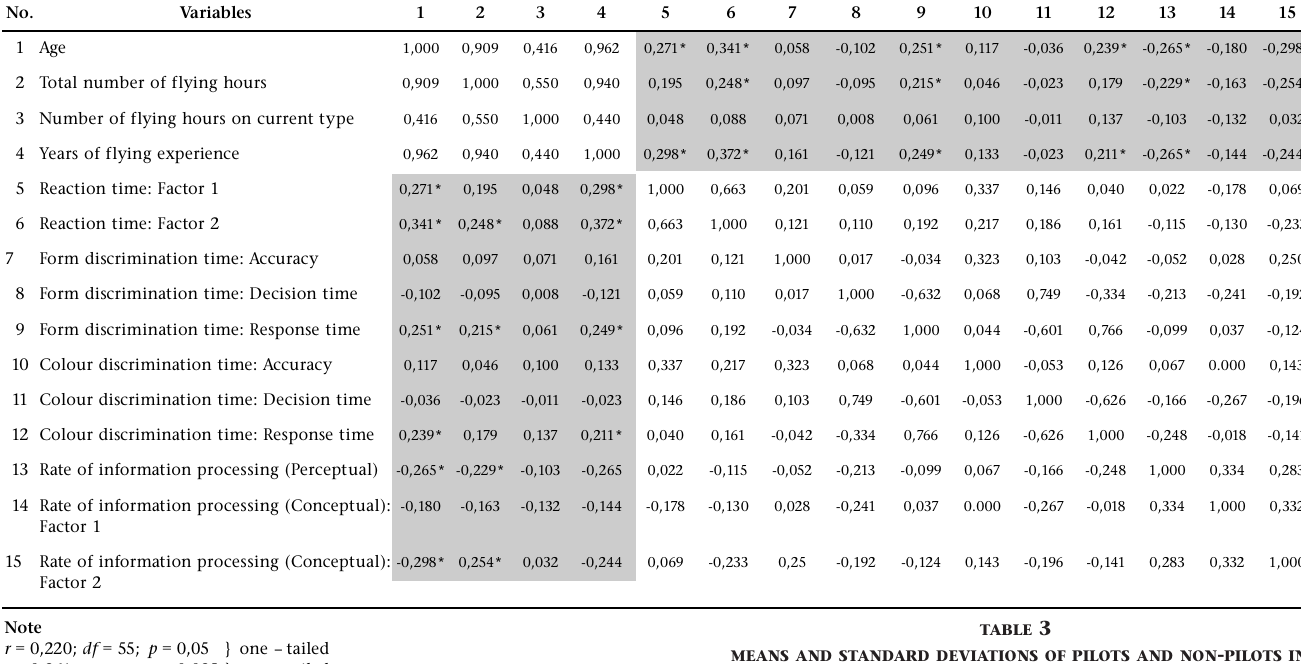
MEANS AND STANDARD DEVIATIONS OF PILOTS AND NON - PILOTS IN RESPECT OF THE CHRONOMETRIC MEASURES